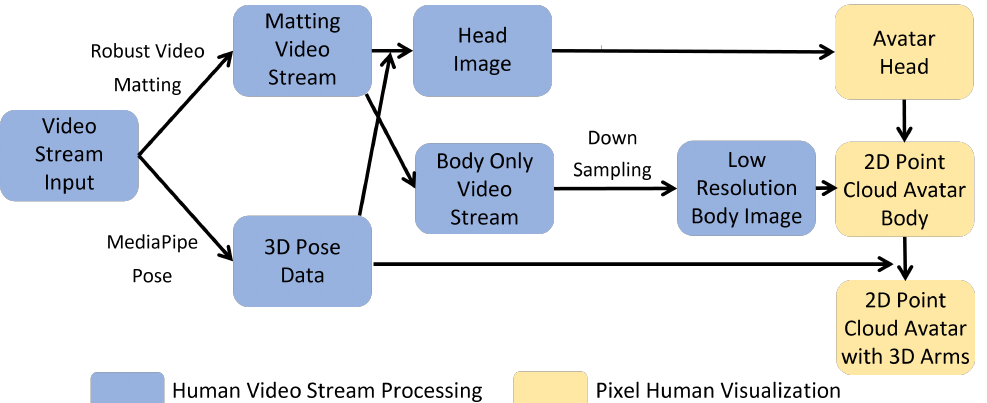
Figure 1. Our framework consists of two components, namely video stream processing and visual- ization. The video stream processing component generates a high-resolution segmented head and low-resolution body video, and extracts 3D pose data. The visualization component uses the results of the video stream processing to visualize a pixel-style avatar.